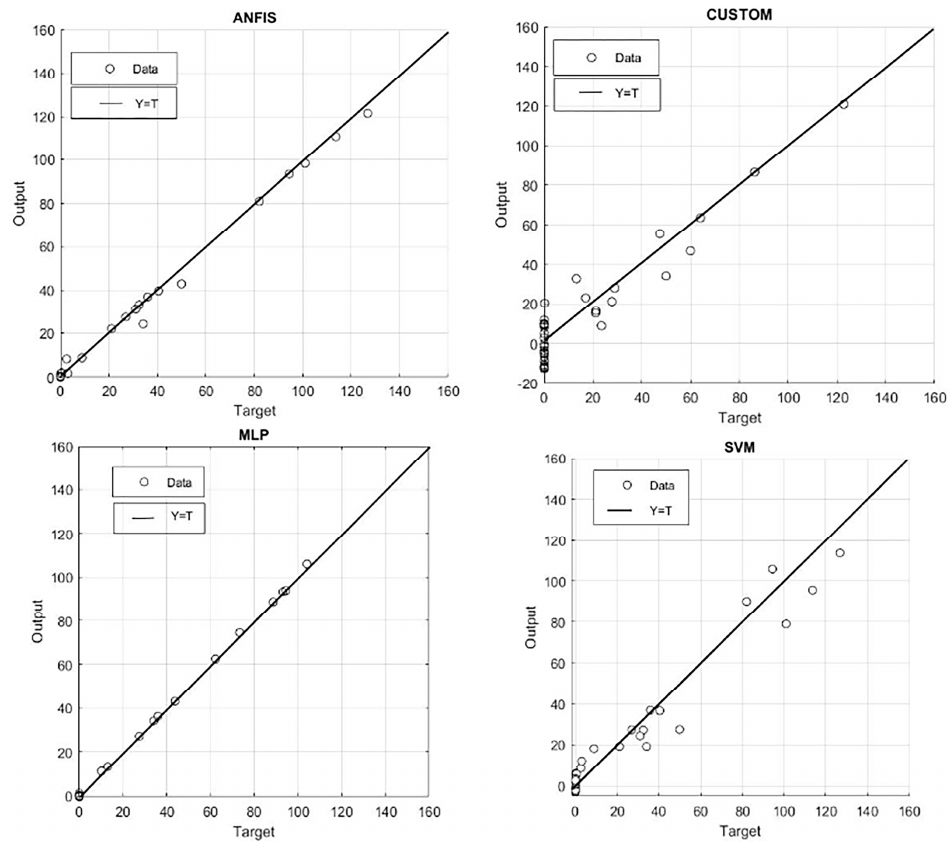
Figure 12. Force simulated (Output) by the ANFIS, custom, MLP, and SVM models in correlation with the force measured (Target) for DMSP − 5: test phase.